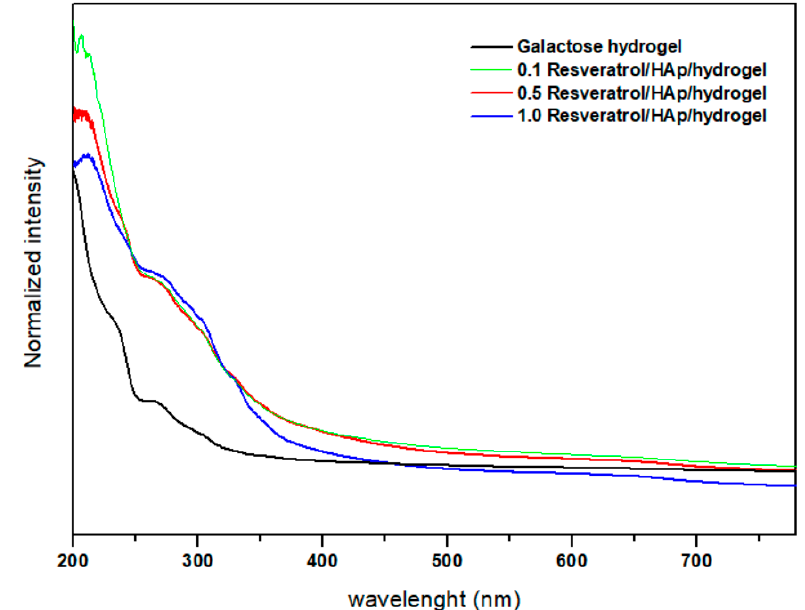
Figure 4. UV–Vis spectra of 3,6-anhydro- α - L -galacto- β - D -galactan hydrogel sample and samples filled with hydroxyapatite and resveratrol.